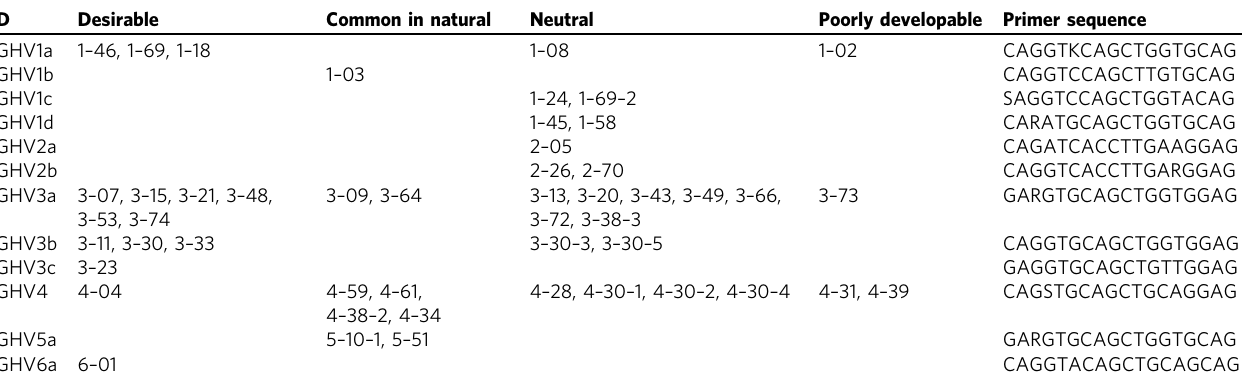
Table 1 IGHV domain developability and primer sequences.